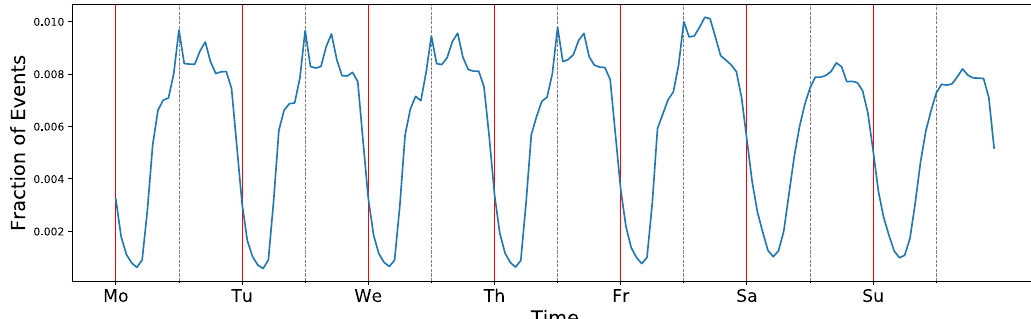
Figure 1. The normalized activity rhythm averaged over the whole student population ( N = 400 ). The horizontal axis spans one week, with time discretized into one-hour bins. The red lines mark midnight and the grey dashed lines indicate